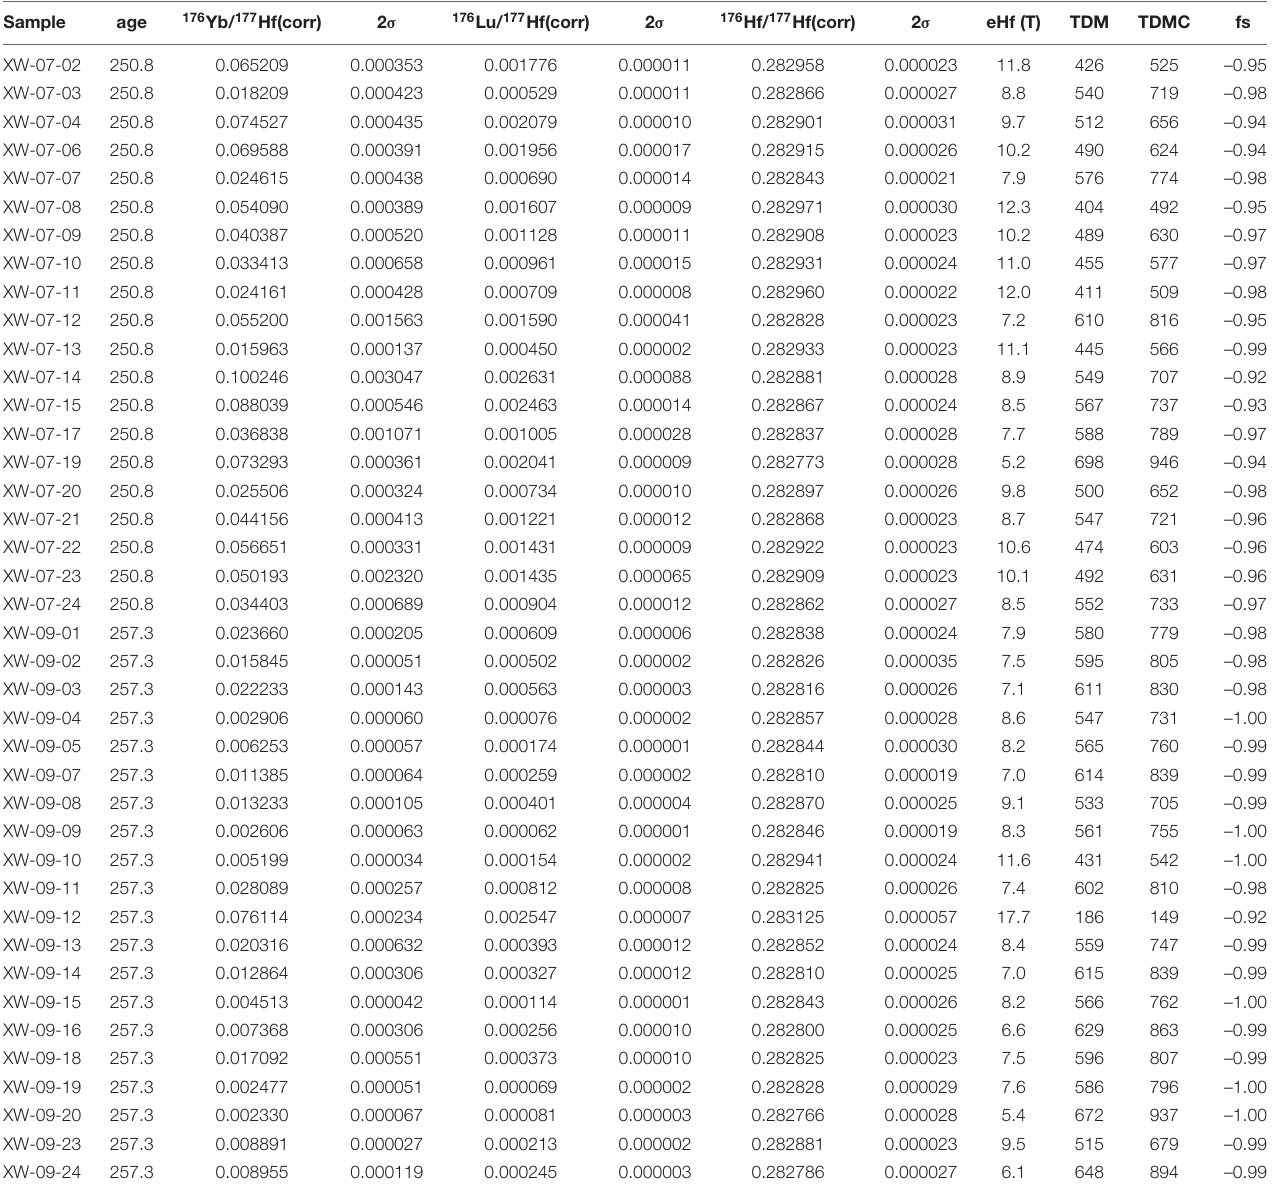
TABLE 2 | MC-ICP-MS zircon Lu–Hf isotopic compositions from the Xiwanggou mafic–ultramafic complex.